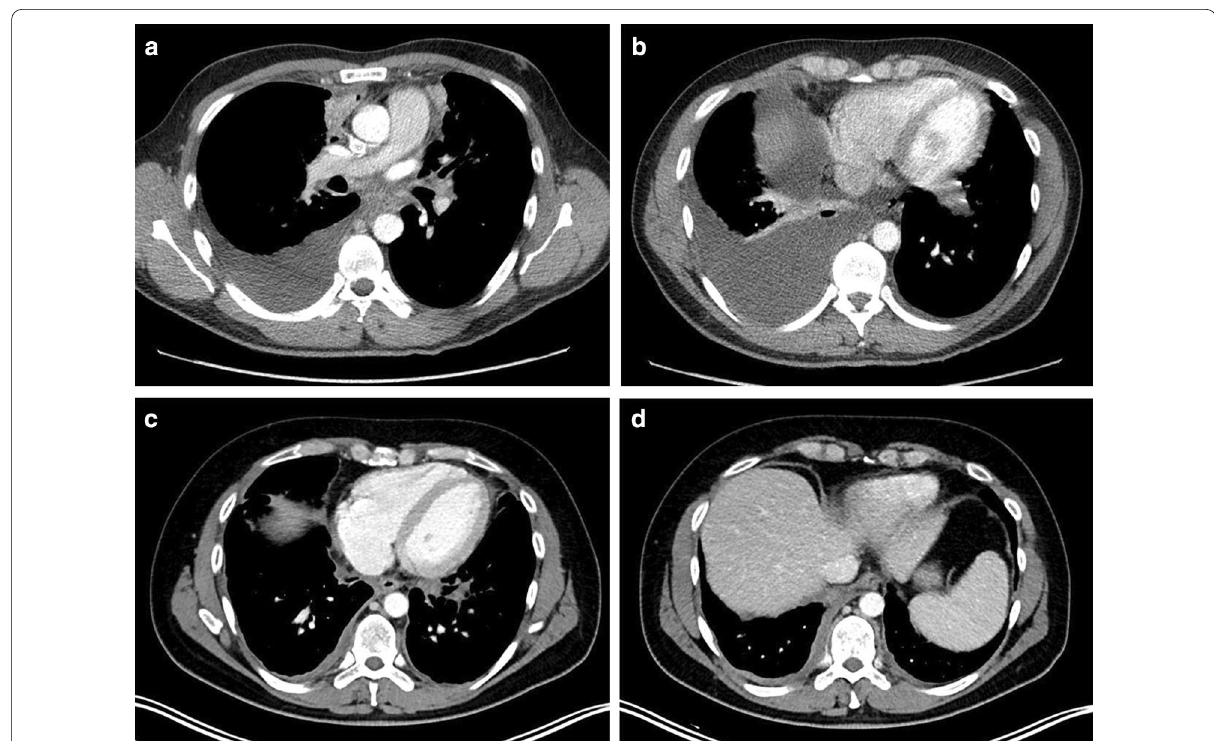
Fig. 1 Diagnosis: primary effusion lymphoma. Technique: contrast-enhanced chest CT. Description: A 41-year-old man with a history of HIV, HHV8, and EBV presented with dyspnea and chest pain. The initial CT examination ( a , b ) shows a prominent unilateral pleural effusion posterior to the right lung. A combination of imaging and clinical findings was suggestive of primary effusion lymphoma, which was histopathologically confirmed. Follow-up CT after treatment ( c , d ) shows a small residual right-sided pleural